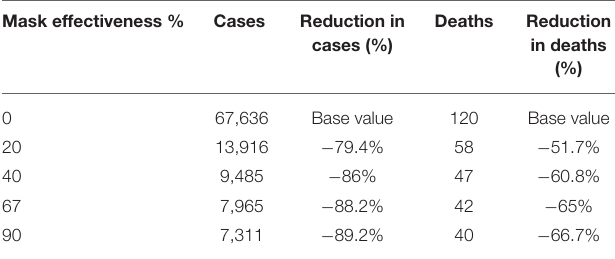
TABLE 4 | Modeled cases and deaths by 1 October by varying effectiveness of masks and 70% uptake of masks. Mask effectiveness